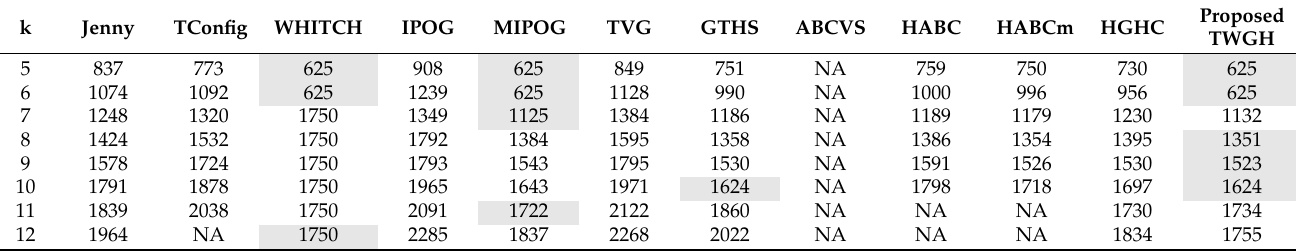
Table 4. CA (N; 4, k, 5) with k varied from 5 to